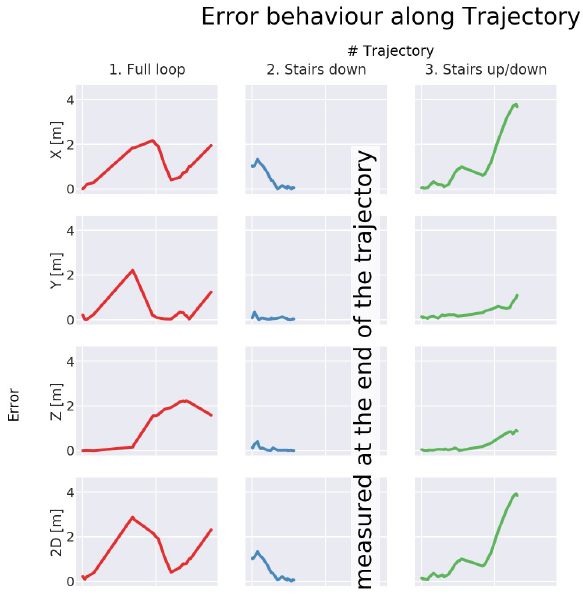
Figure 5. Behaviour of the absolute errors along the trajectories As can be seen in Figure 5, drifts increase with the distance travelled from the start location. The 2D error of the first trajectory (full loop) first increases but after 136 meters starts to decrease again until around 240 meters and then starts to increase again. This phenomenon is only present in the first trajectory. All errors of the second trajectory seem to decrease,